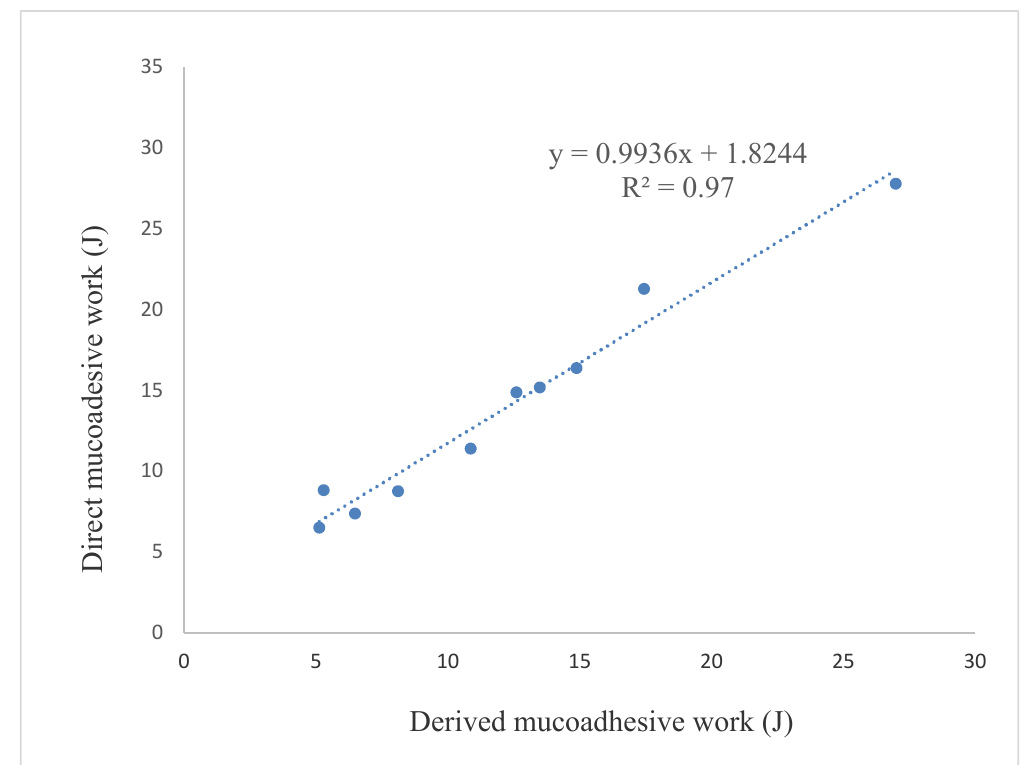
Figure 4. Correlation between the direct and the derived mucoadhesive work.